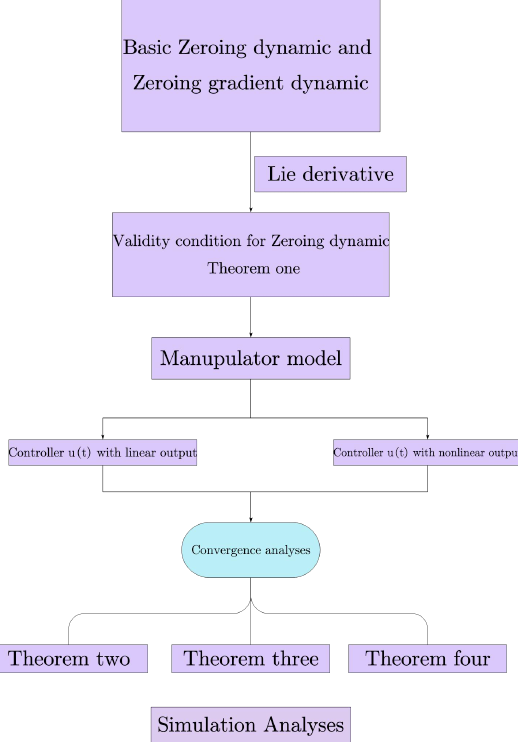
Figure 1. Structure of the main finding of this